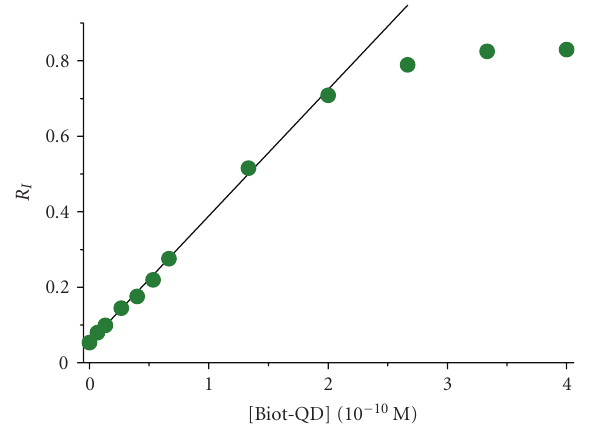
Figure 6: Intensity ratio R I (cf. (5)) over Biot-QD concentration for the Tb L -Strep + Biot-QD immunoassay after 8 hours incubation. Linear fit for LOD calculation shown as solid